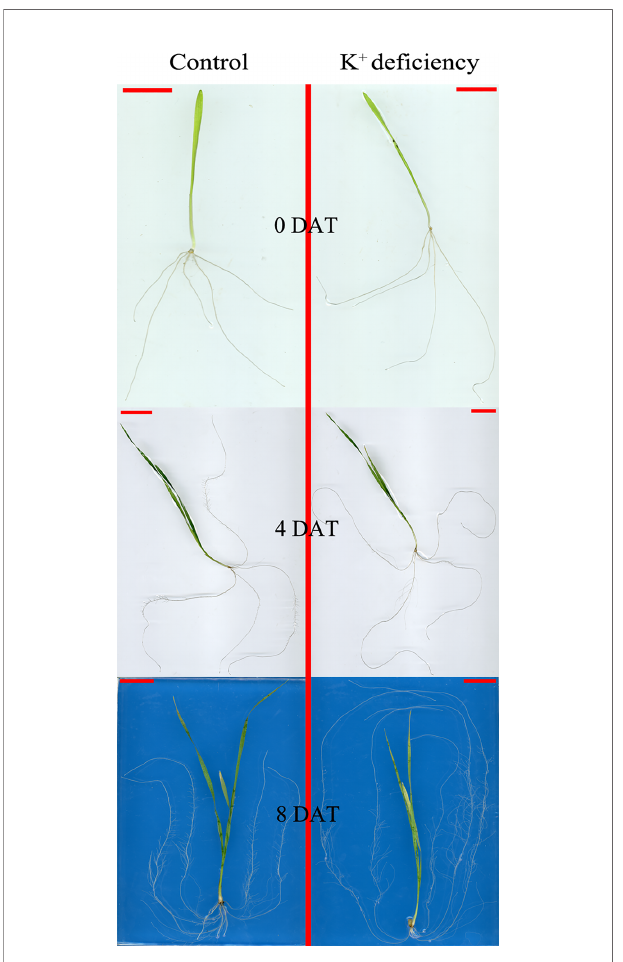
FIGURE 1 | Seedling morphology difference between high K + control group and low K + treatment group at 0, 4 and 8 days after transfer day (DAT).